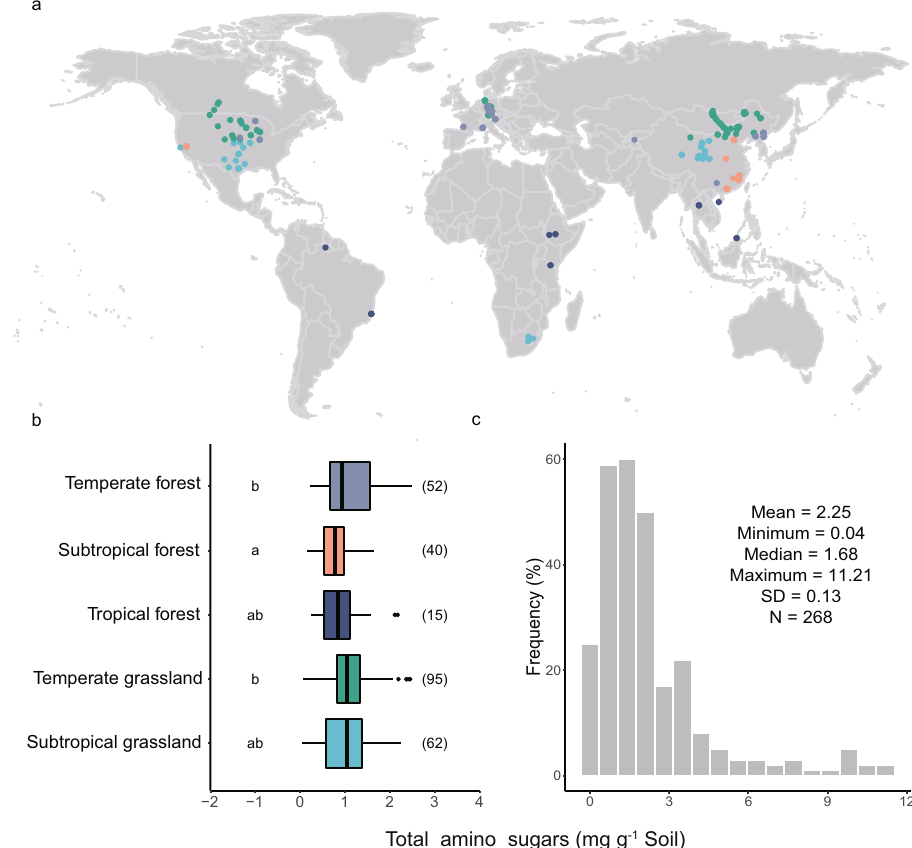
Fig. 1 Datasets used in the study. a Study sites. b Kruskal – Wallis test between different ecosystems and climatic zones; letters in the fi gure indicate signi fi cant differences such that conditions with the same letters are not signi fi cantly different. c Frequency distribution histogram of original data for amino sugars; numbers in the graph show basic statistical information. b Central lines in the boxes represent medians, left edges of the boxes represent fi rst quartiles, right edges of the boxes represent third quartiles, whiskers indicate 1.5-fold inter-quartile ranges, and dots beyond whiskers represent outliers.